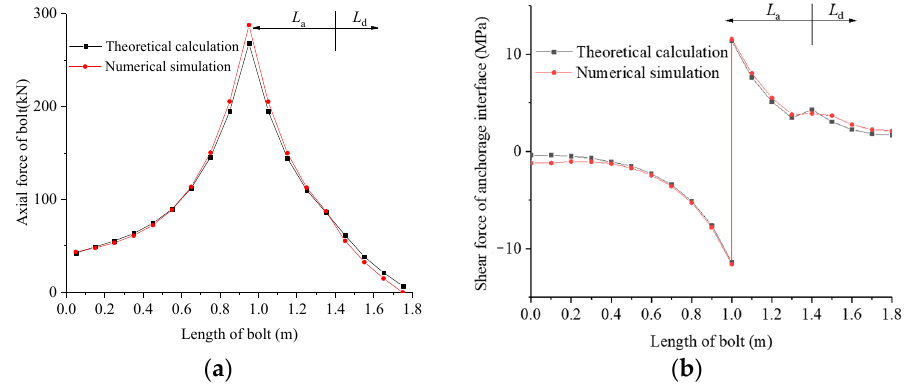
Figure 5. Comparison between the numerical simulation and theoretical analysis. ( a ) Axial force of the bolt. ( b ) Shear force of the anchorage interface.